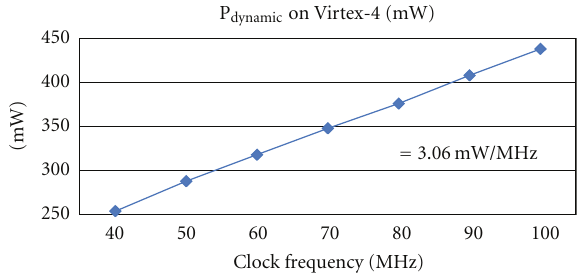
Figure 14: Impact of the clock frequency to the dynamic power consumption of a uniprocessor design on a